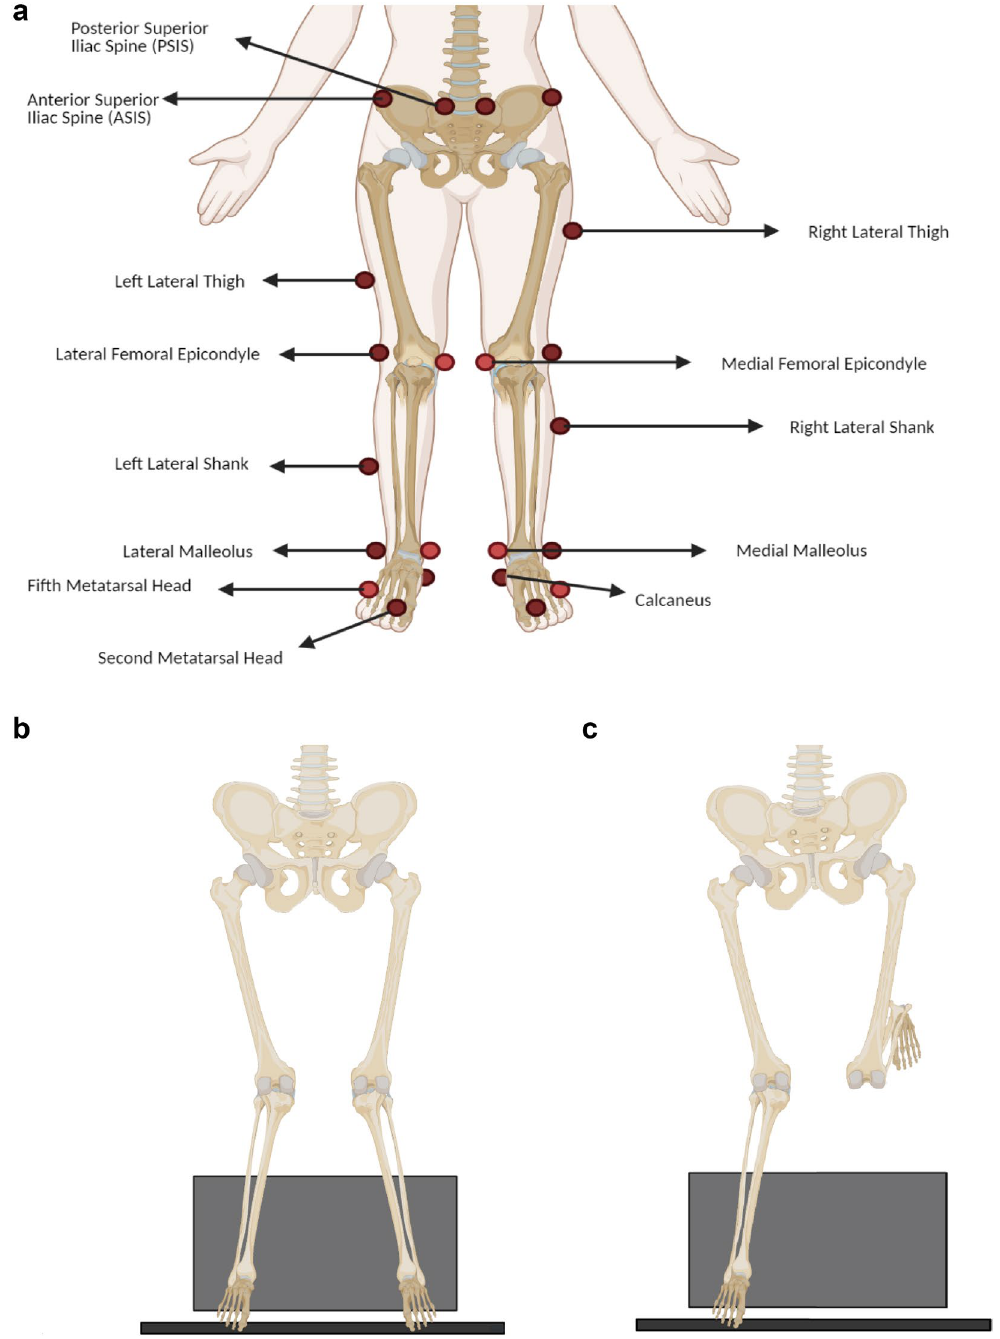
Figure 1. Lower extremity marker placement: 20 retroreflective markers based on the modified plug-in-gait marker system/B: DLL task, and C: SLL task from a box (30 cm height from the